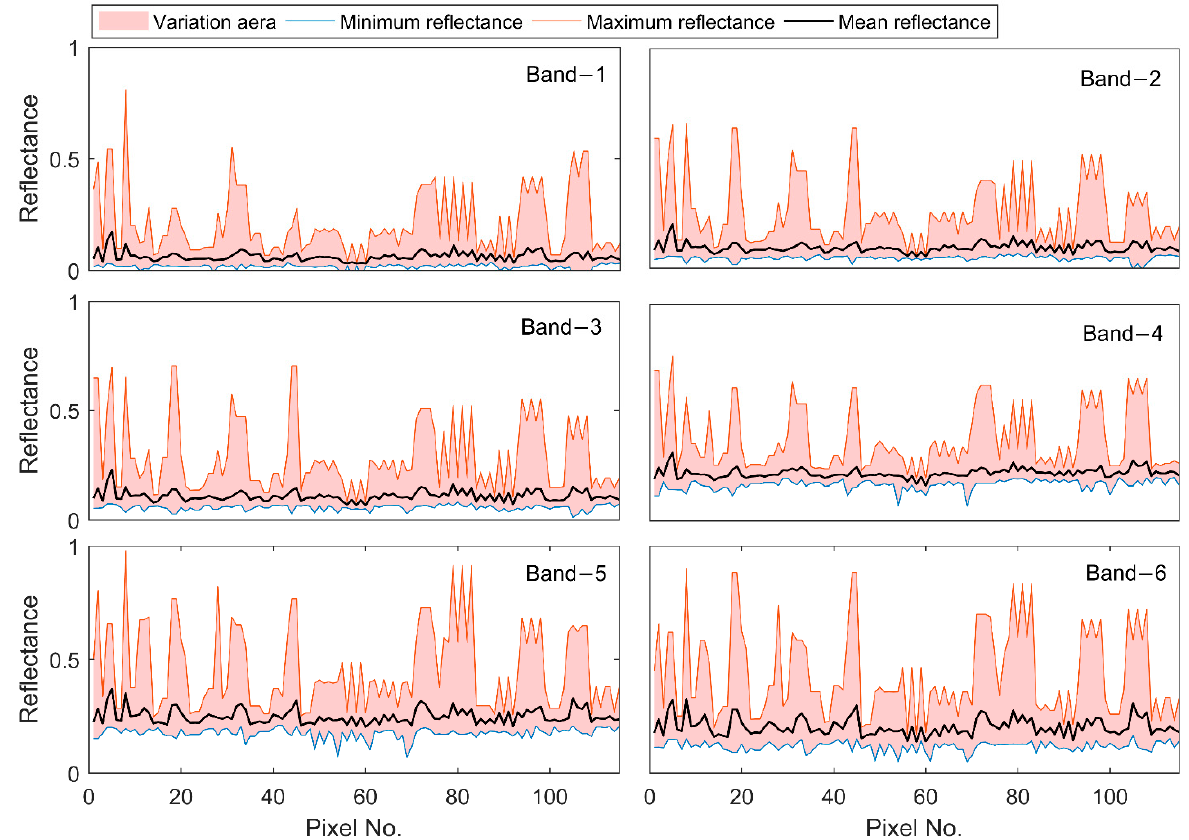
Figure 10. Reflectance variation of 5 × 5 artificial pixels from Landsat − 8 OLI.